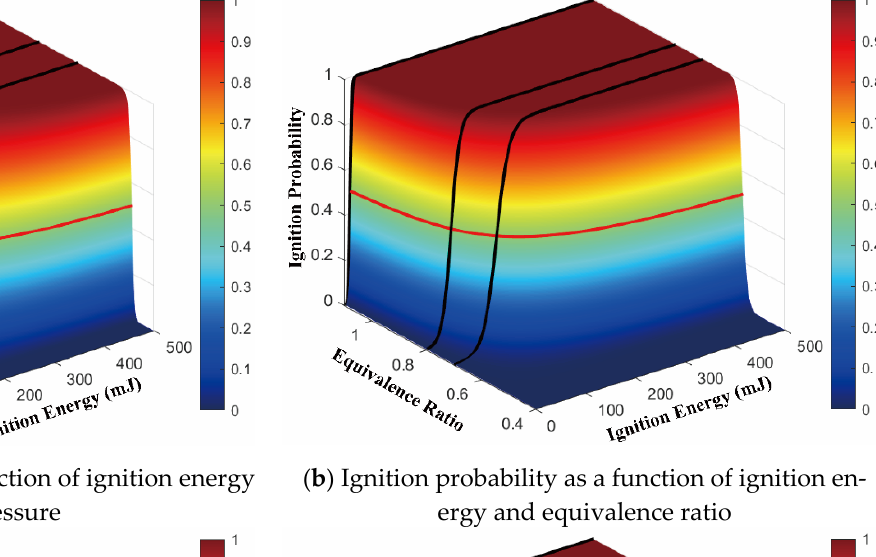
( b ) Ignition probability as a function of ignition en- ergy and equivalence ratio